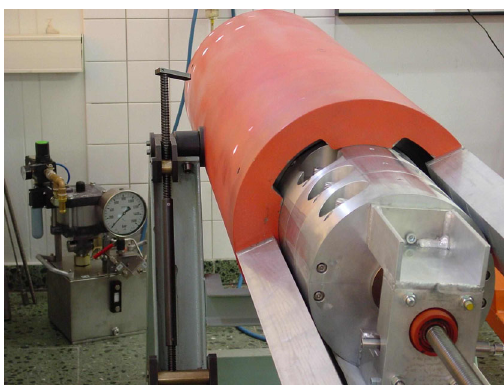
FIG. 18. Pressure and radius growth vs the axial displacement on the second stage of the expansion.